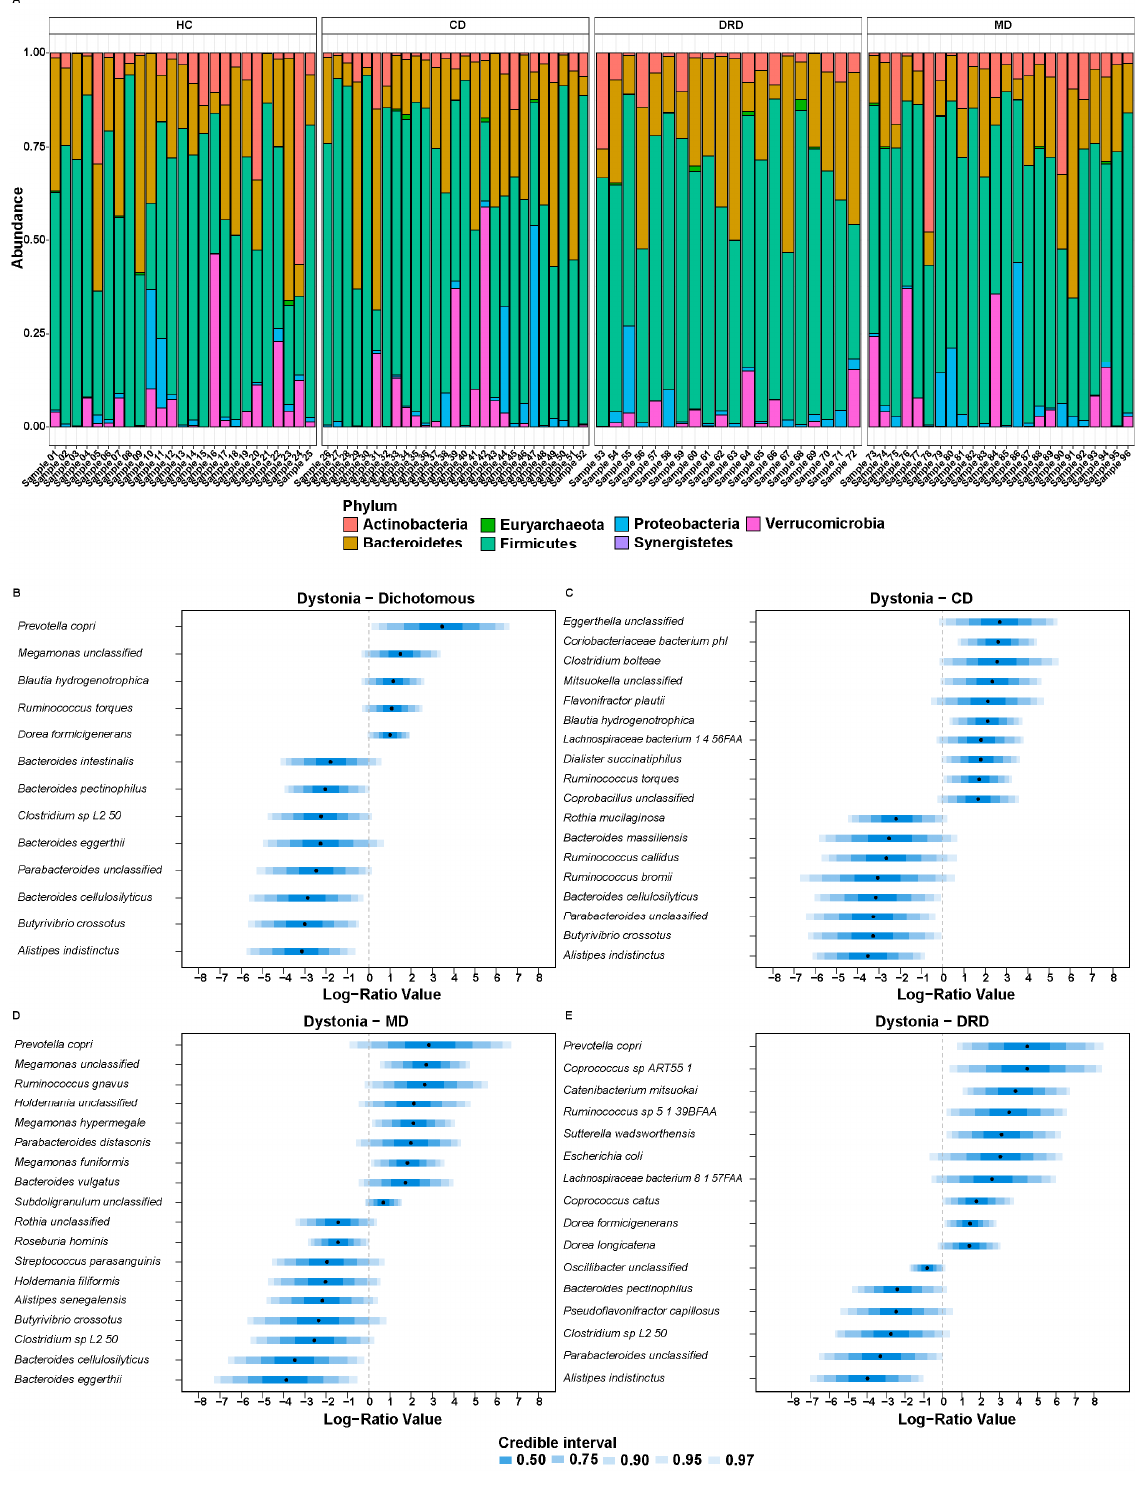
Figure 2. ( A ). Phylum barplot for dystonia patients and healthy controls. ( B – E ). Results of a pibble model showing differences in species level relative abundance between dystonia patients and healthy controls with a 90% credible interval cut-off. Plots show the comparison between ( B ) the whole dystonia group and the healthy controls, ( C ) cervical dystonia (CD) and healthy controls, ( C ) dopa-responsive dystonia (DRD) and healthy controls and ( E ) myoclonus dystonia (MD) compared to healthy controls.